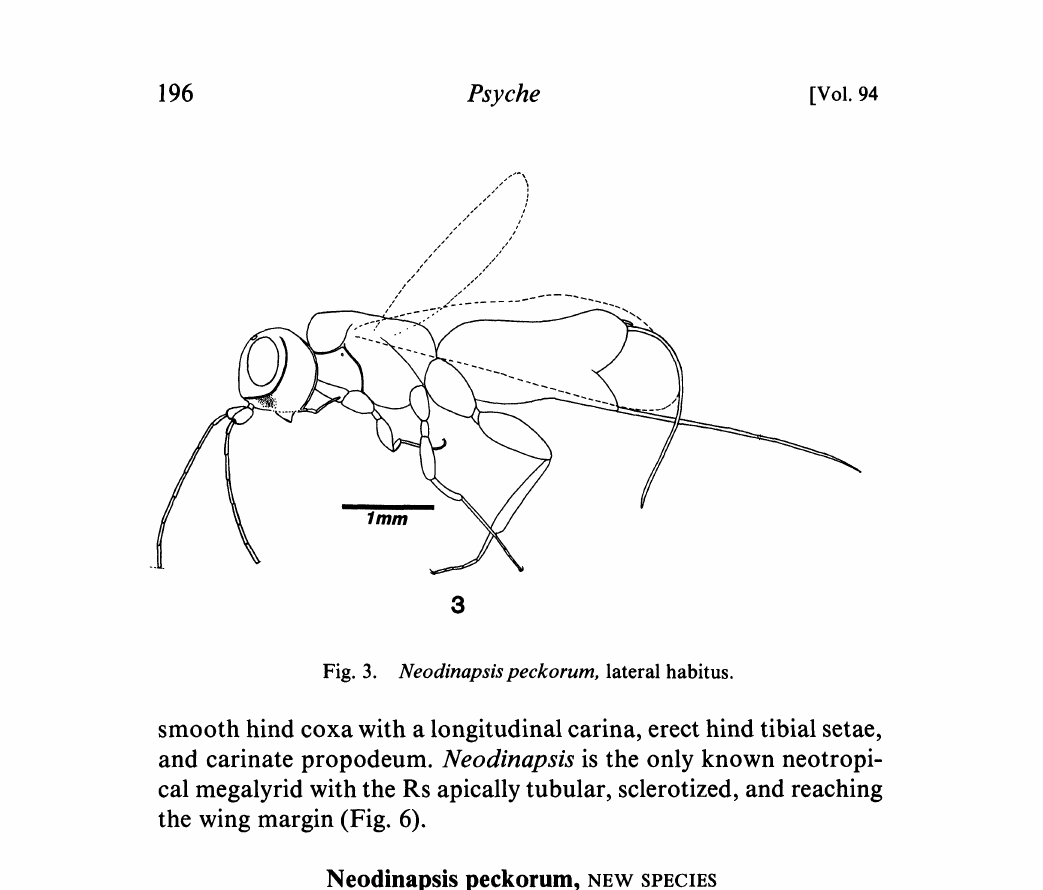
Fig. 3. Neodinapsispeckorum, lateral